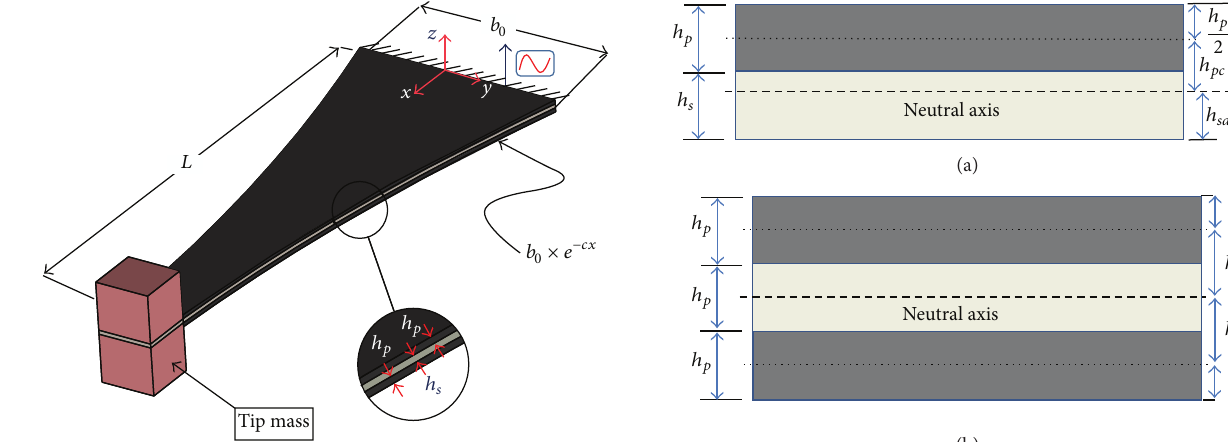
Figure 1: Piezoelectric energy harvester.